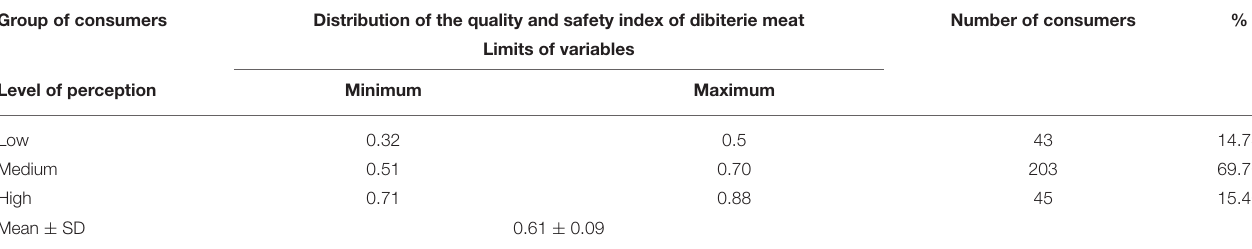
TABLE 3 | Characterization of the levels of perception on the quality and safety of dibiterie meat ( n = 291). Group of